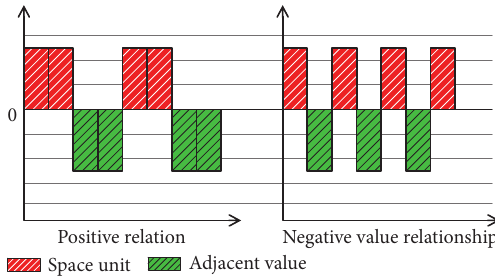
Figure 4: Illustration of positive value relationship and negative value relationship.